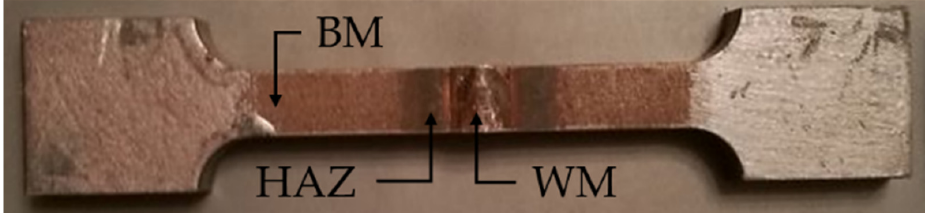
Figure 5. Areas of specimens observed by microscope: base metal—BM, heat affected zone—HAZ and weld metal—WM.